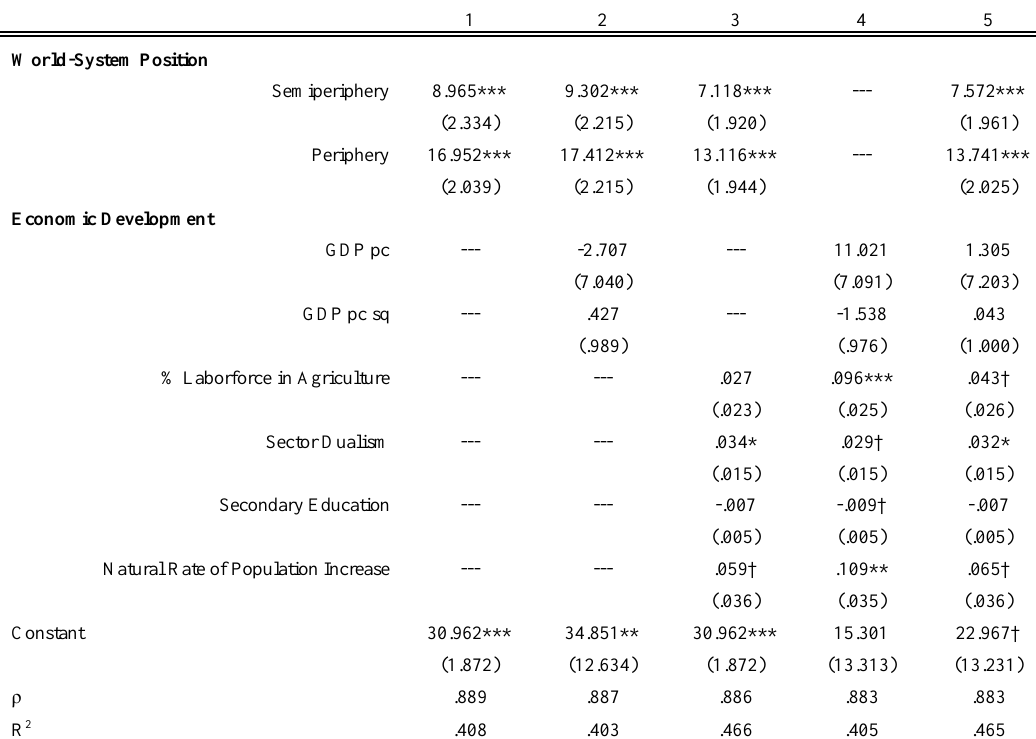
Table 5. AR(1) Corrected Random Effects Regression of Income Inequality on World- System Position and Economic